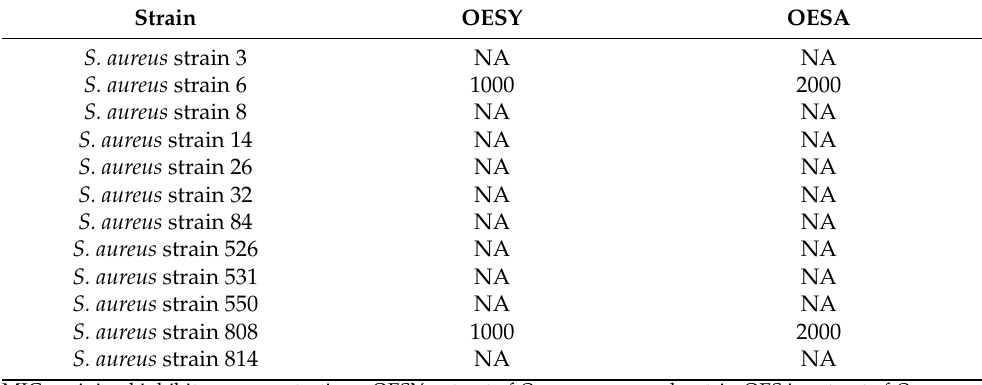
Table 3. MICs of OESY and OESA (expressed as µ g/mL) against clinical isolates of S. aureus . Strain